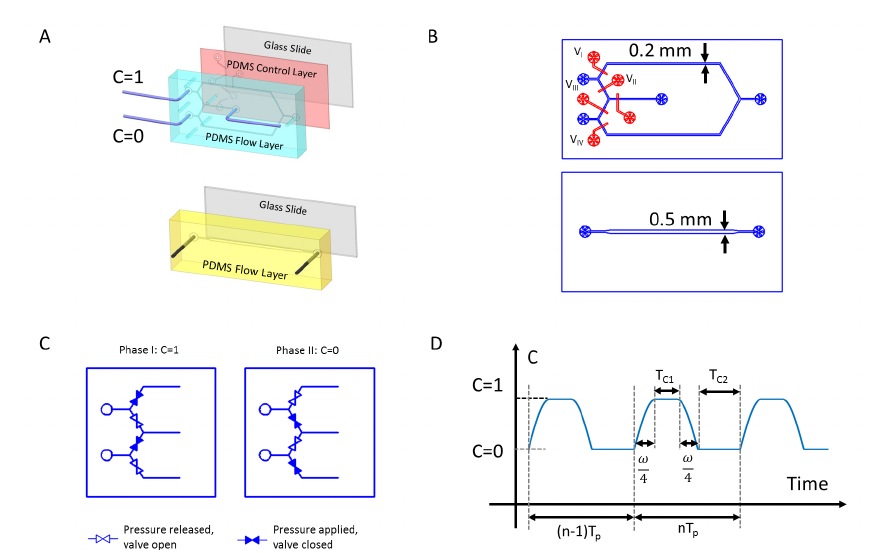
Figure 2. Structures of the Spatio-Temporal Concentration Controller. ( A ) 3D structure of Signal generator (Oscillator) and Module Connector (Integrator), the Oscillator consists of three layers, the PDMS structure layer has flow channels patterned. The channel is molded using positive photo resist which produces a semi-cylindrical cross-section for complete sealing of the micro valve. The second layer is a thin PDMS membrane with controlling valves when the air pressure ( ∼ 20 psi) is applied, valve will seal the channel. The third layer is glass slide to support the entire structure. All layers are bounded to each other using plasma bonding. The Integrator is a single microfluidic channel with depth 25 µm. The PDMS layer is also bounded to a glass slide; ( B ) Drawings of the oscillator and integrator ( C ) Concentration signal generation achieved by combination of valve status; ( D ) Function generated by the oscillator.